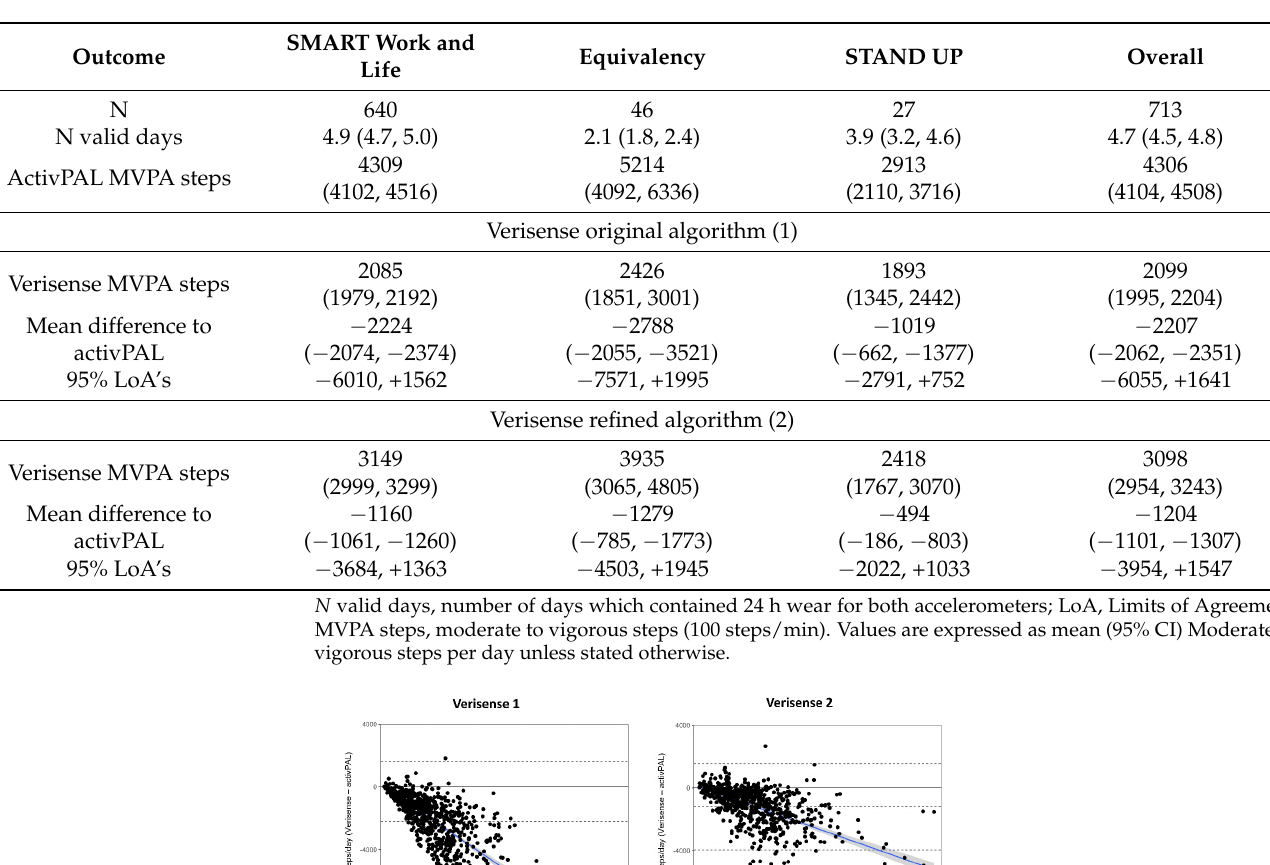
Table 4. Agreement between MVPA steps derived by the activPAL and MVPA steps derived by the Verisense algorithms applied to wrist accelerometer data.